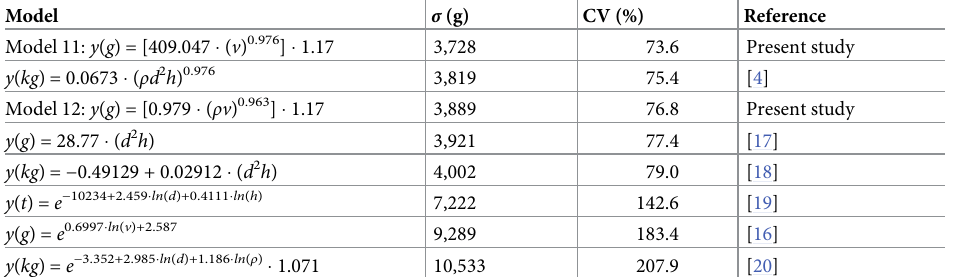
Table 7. Comparison of tree aboveground biomass models, based on destructive sampling data of the present study.